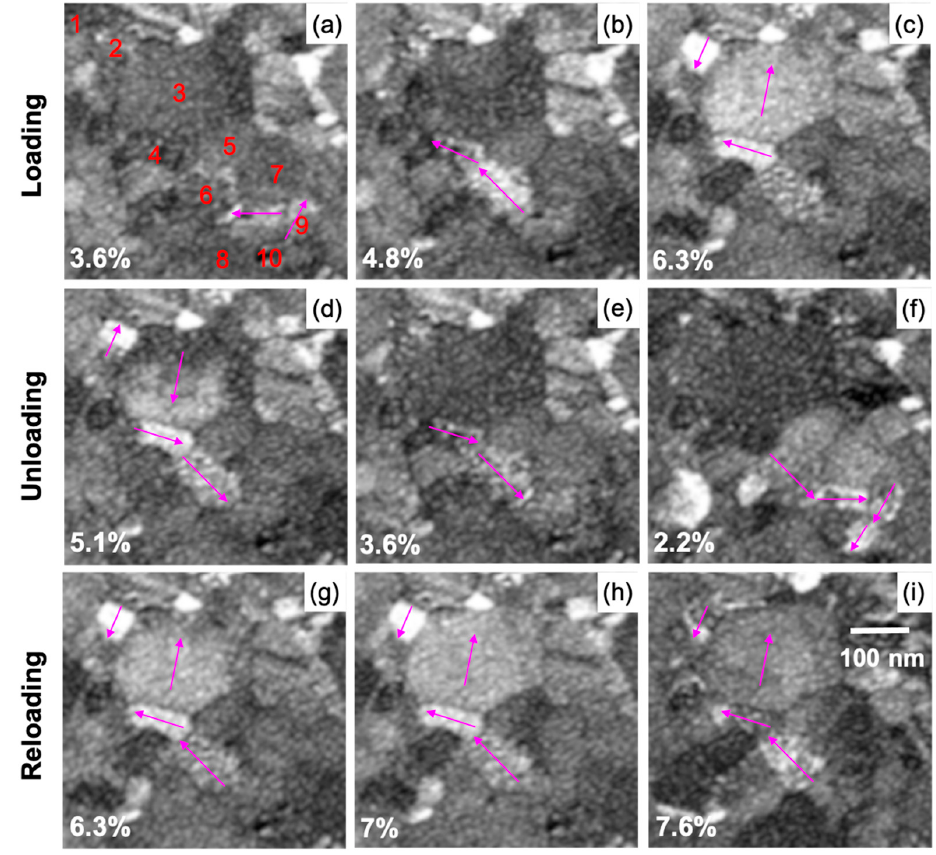
Figure 6. µ p-STEM-ADF images acquired after each ACOM map acquisition showing cooperative rotation of grains: ( a – c ) loading, ( d – f ) unloading, and ( g – i ) reloading. The corresponding strain at every deformation state is indicated in the image. Grains in ( a ) are numbered as in Figure 2b.